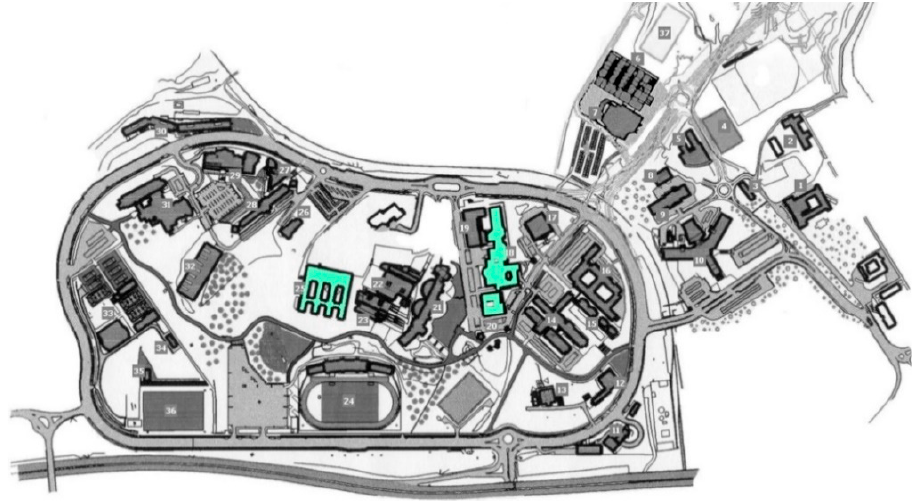
Figure 14. Murcia University’s Espinardo campus showing the Faculty of Economics and Business (FEB) and Faculty of Veterinary Medicine (FVM). Drawing: Authors.